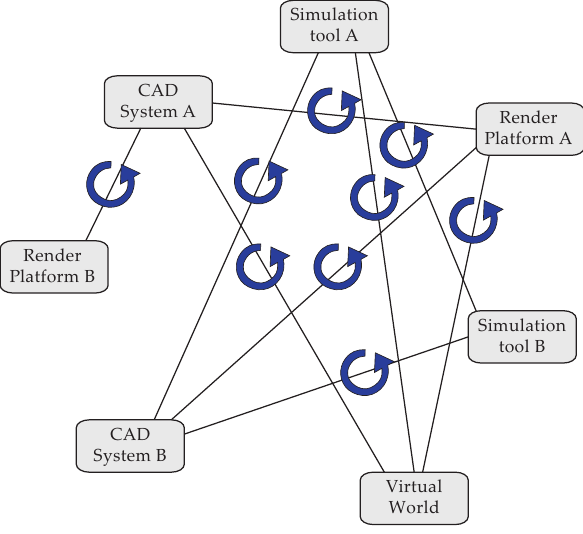
Figure 2. The traditional information flow between information systems: sharing information “in the wild”. Interface points (circular arrows) are points where information is interpreted from one information structure into the other. In this case, this happens only among information systems (in blue).